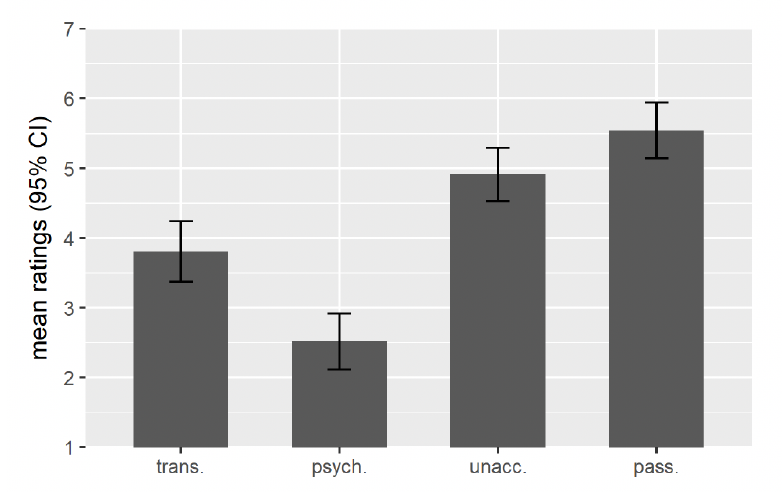
Figure 10. Acceptability of extraction of über wen ‘about whom’ from NP in German (Konietzko forthcoming).